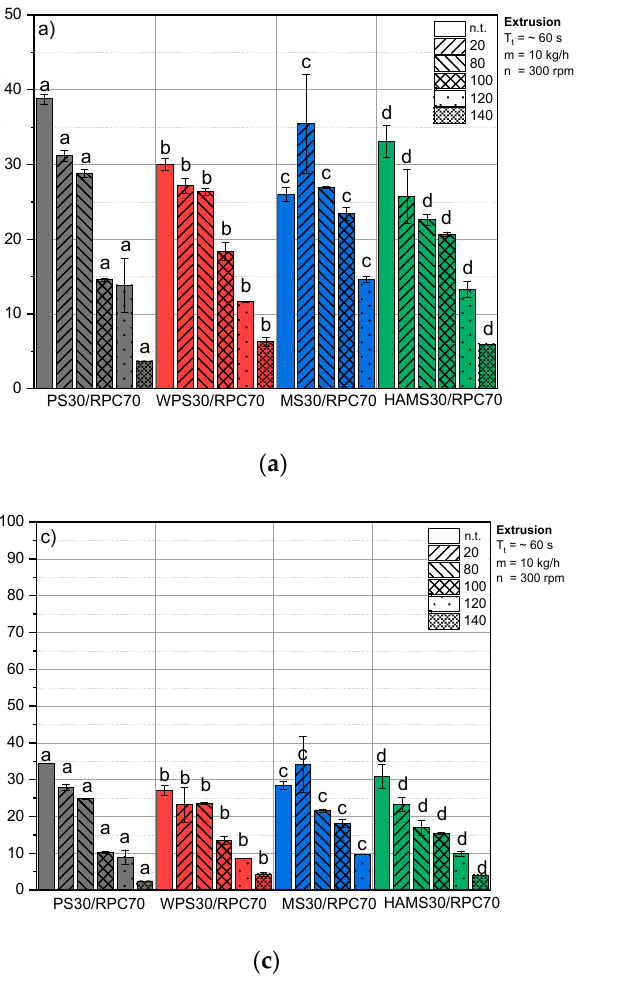
Figure 3. Extractable protein content (g/100 g d.m.) and protein solubility (%) at pH 7 as a function of ( a , c ) barrel temperature T B (20, 80, 100, 120 or 140 °C) and ( b , d ) treatment temperature T T (25, 80, 100, 120, 140) of starch/RPC blends containing 70 g/100 g w.b. RPC and 30 g/100 g w.b. potato starch (PS), waxy potato starch (WPS), maize starch (MS) or high ‐ amylose maize starch (HAMS). Mean values with different superscript letters indicate significant differences ( p < 0.05) between the starch types based on a two ‐ way analysis of variance (ANOVA). Where appropriate, the mean values were compared using Tukey’s honest significance test. n.t. = not treated.